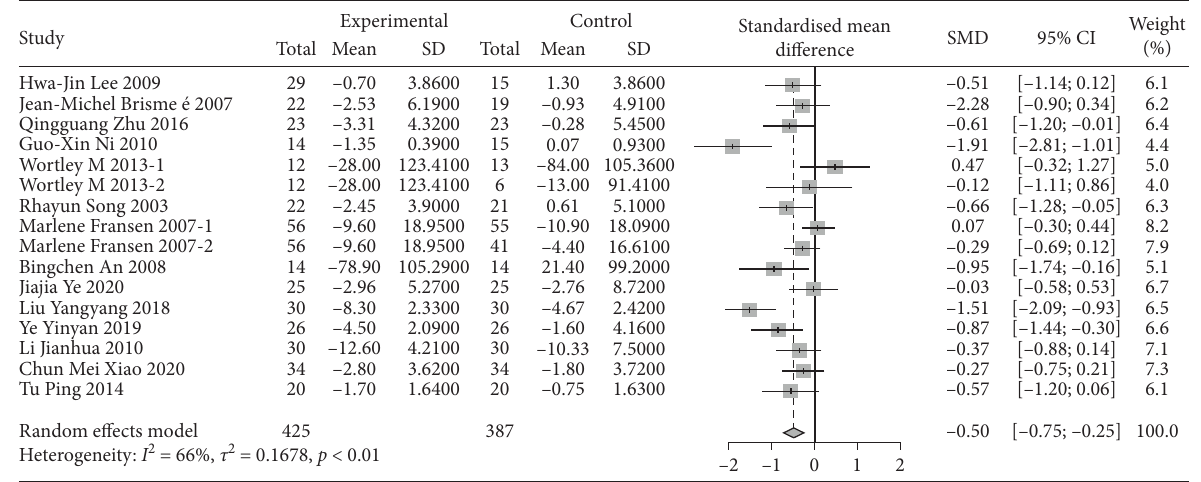
Figure 7: Meta-analysis of WOMAC pain comparison between the traditional Chinese exercise group and the control group.